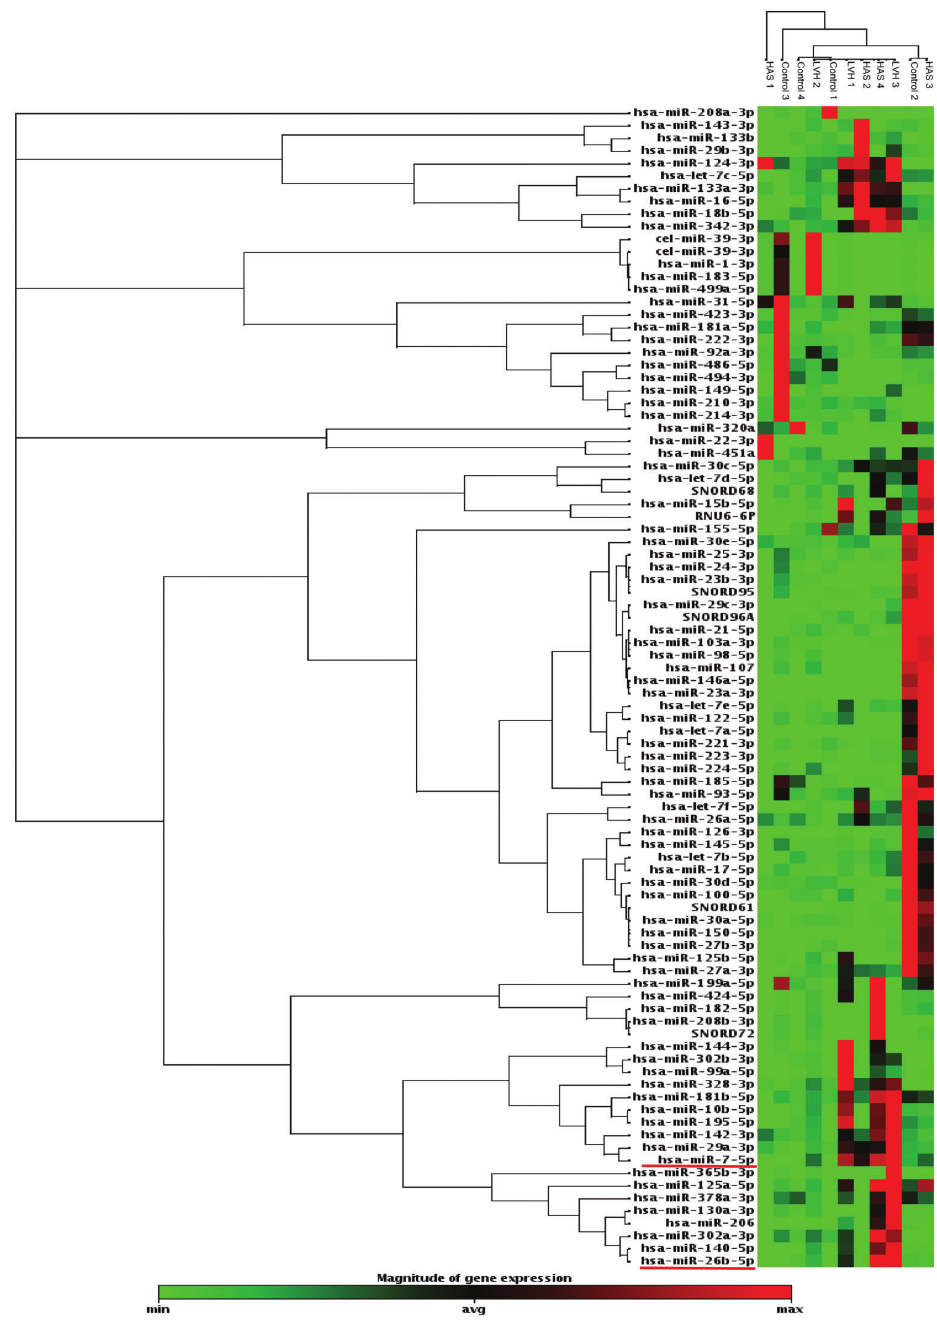
Figure 1. Heat map illustrating the expression patterns of upregulated and downregulated miRNAs in hypertensive patients with left ventricular hypertrophy (LVH). Upregulated miRNAs are indicated by red while downregulated miRNAs are indicated by green. The two candidate miRNA markers miR-7-5p and miR-26b-5p are underlined in the plasma of HCM patients. However, correlation with determines a signi fi cant release of miRNAs into the left ventricular hypertrophy parameters holds true for only bloodstream: the circulating levels of both cardiac and a few miRNAs, whereas only miR-29a is signi fi cantly non-cardiac-speci fi c miRNAs are signi fi cantly increased in